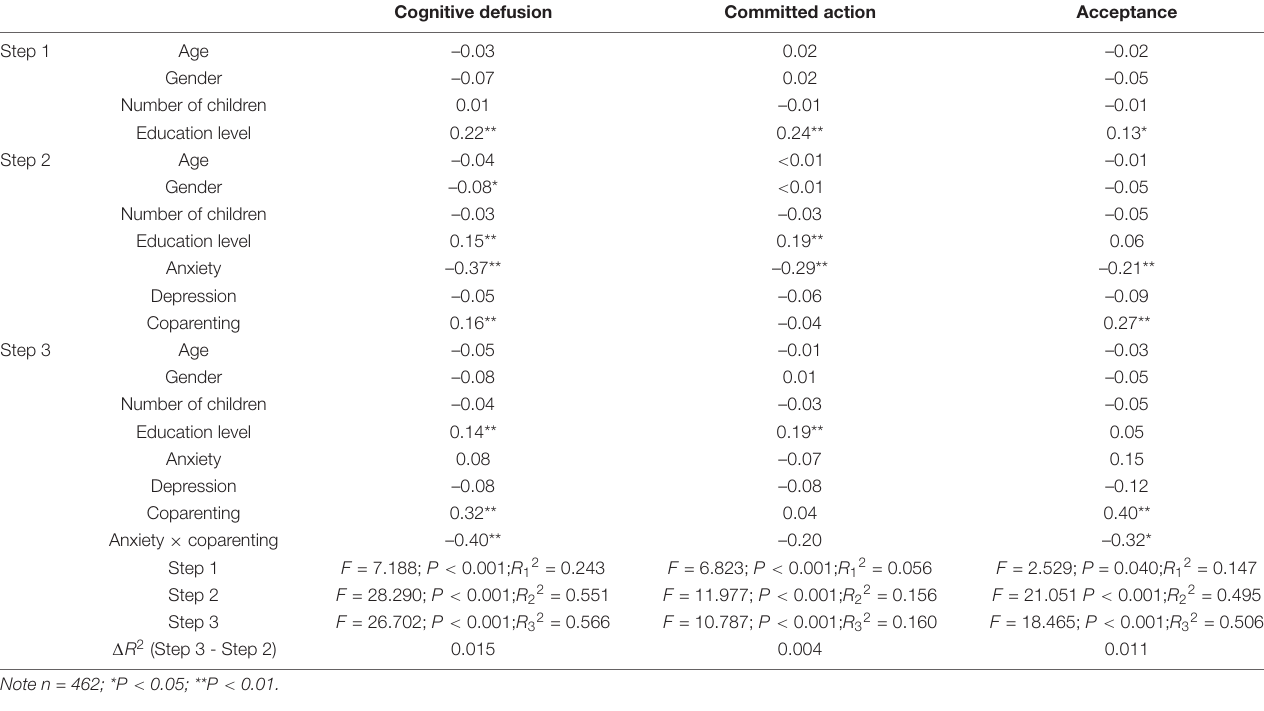
TABLE 5 | The regression models for cognitive defusion and acceptance (beta, standardized regression